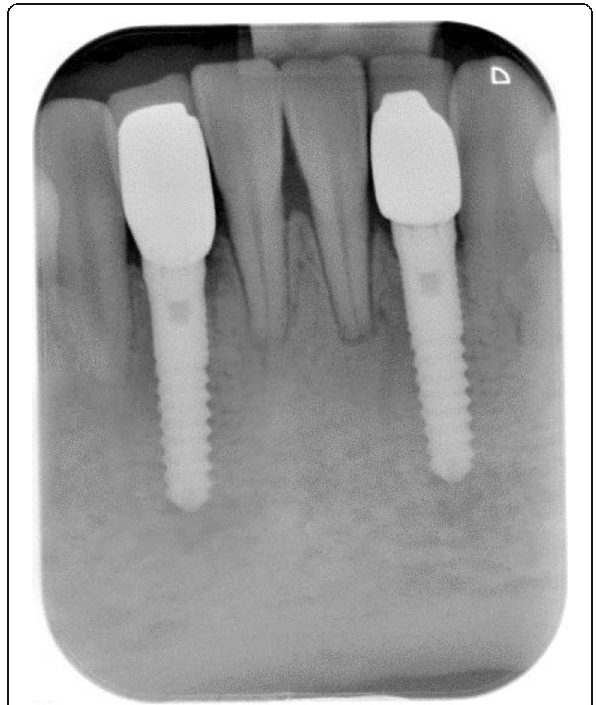
Fig. 7 Radiological follow-up of the same patient 1 year